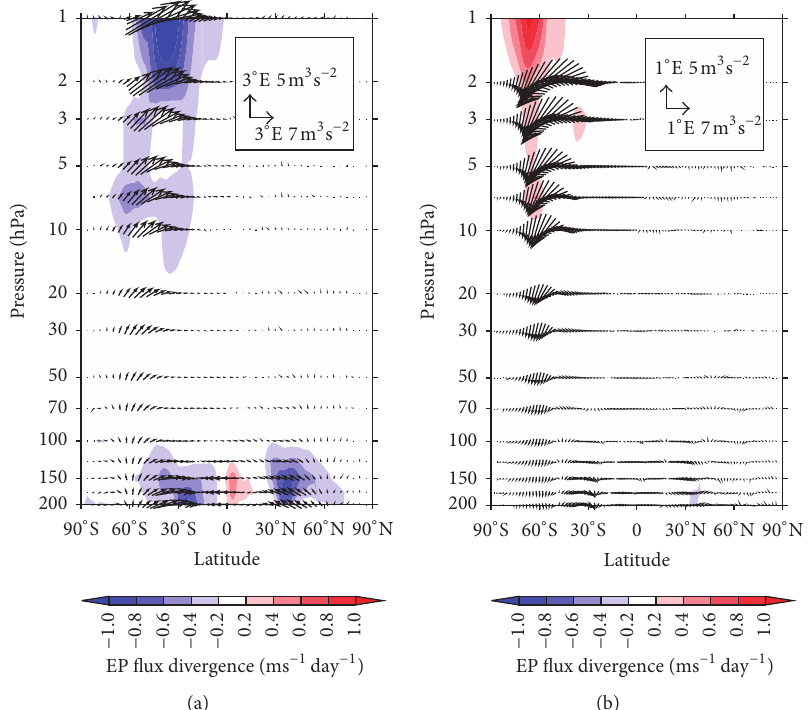
Figure 8: (a) Climatological EP flux for the period between 1994 and 2005 and (b) anomalous EP flux during the “postwarming” period. Colors indicate EP flux divergence.